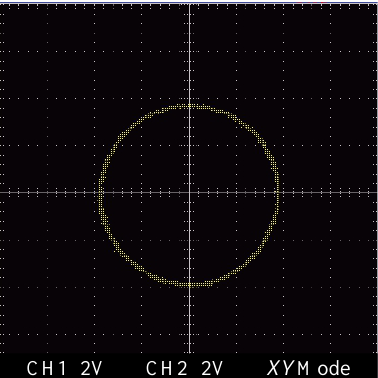
Figure 10. Output Lissajous circle of the MHI.